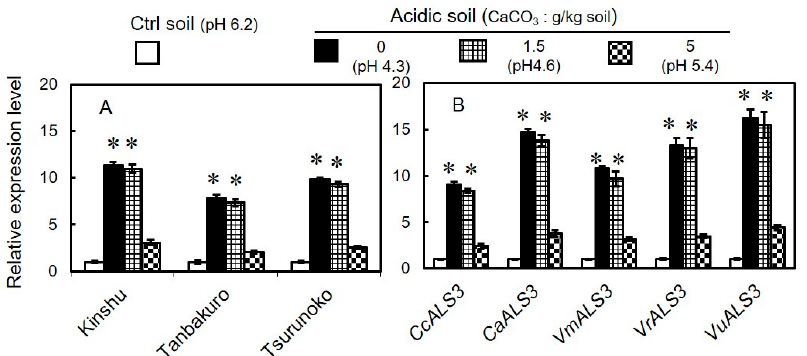
Figure 5. Expression level of GmALS3 in soybean varieties and its orthologs in other legumes grown in Al-toxic and nontoxic soils. ( A ) GmALS3 expression levels were quantified in the shoots of three soybean genotypes (Kinshu, Tanbakuro and Tsurunoko) grown in artificial soils; ( B ) expression level of GmALS3 orthologs in the shoot of various legumes ( Cajanus cajan, Cicer arietinum, Vigna mungo , Vigna radiata and Vigna unguiculata ) grown in artificial soils. Plants were grown for two weeks in neutral soil (addition of CaCO 3 2 g/kg soil) as a control and in acidic soil with addition of different levels of CaCO 3 (0, 1.5 and 5 g/kg soil) as a treatment. Expression level quantified by qRT-PCR. GmUBQ10 and Actin (for other legumes) were used as an internal standard. Data given as mean and ± SE ( n = 3). Asterisks indicate significant differences (Student’s t- test, p < 0.05) compared to control soil.